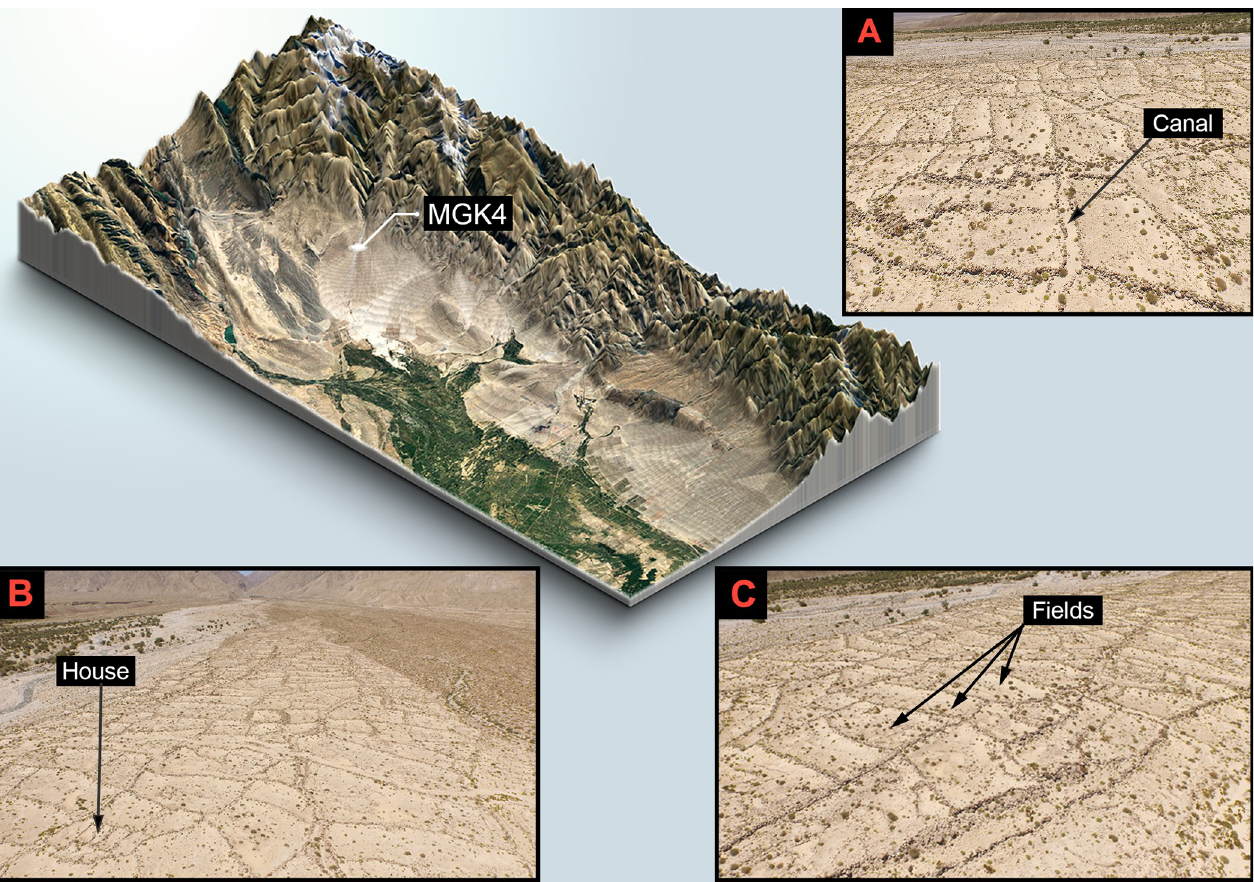
Fig 2. Geographical setting of MGK4 and aerial photos of the site. (A) Aerial photo of MGK4 (from east to west). (B) Aerial photo of MGK4 (from southeast to northwest). (C) Aerial photo of MGK4 (from southeast to northwest).